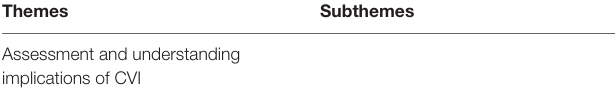
Registered Blind or diagnosis reported partially sighted by parent reported by